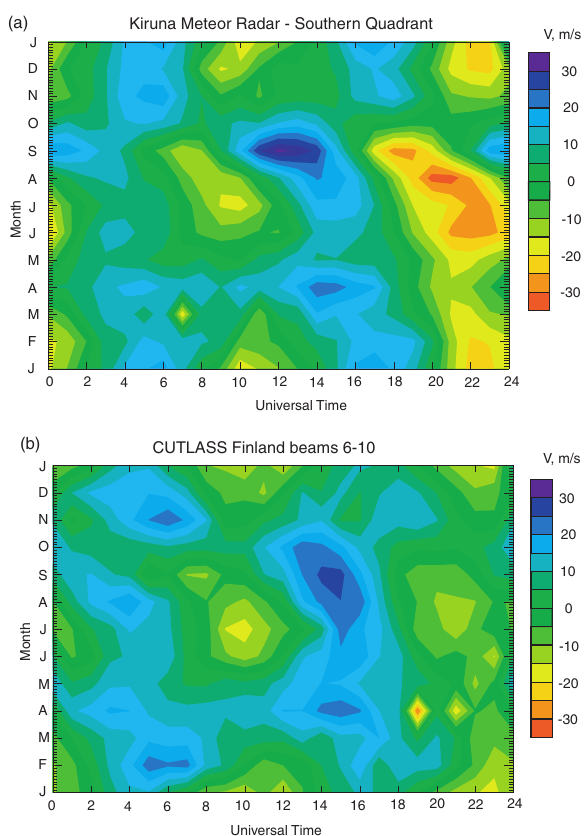
Fig. 9. Seasonal and diurnal meridional winds around 96km for (a) the Esrange VHF radar southern quadrant and (b) SuperDARN Finland HF radar beams